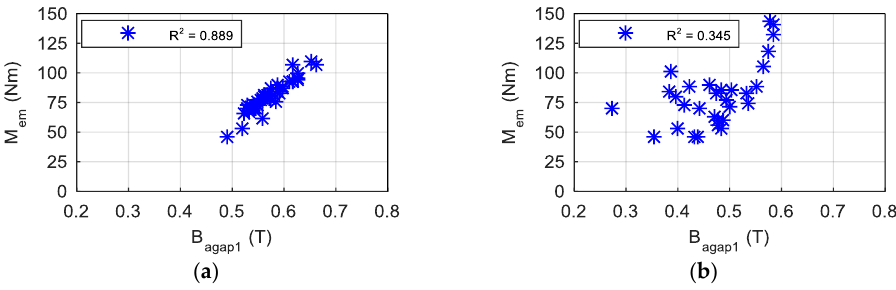
Figure 10. Mean electromagnetic torque ( M em ) versus the first harmonic of the air-gap flux density ( B agap 1 ) for ( a ) ISDW and FSDW machines; ( b ) FSCW machines.